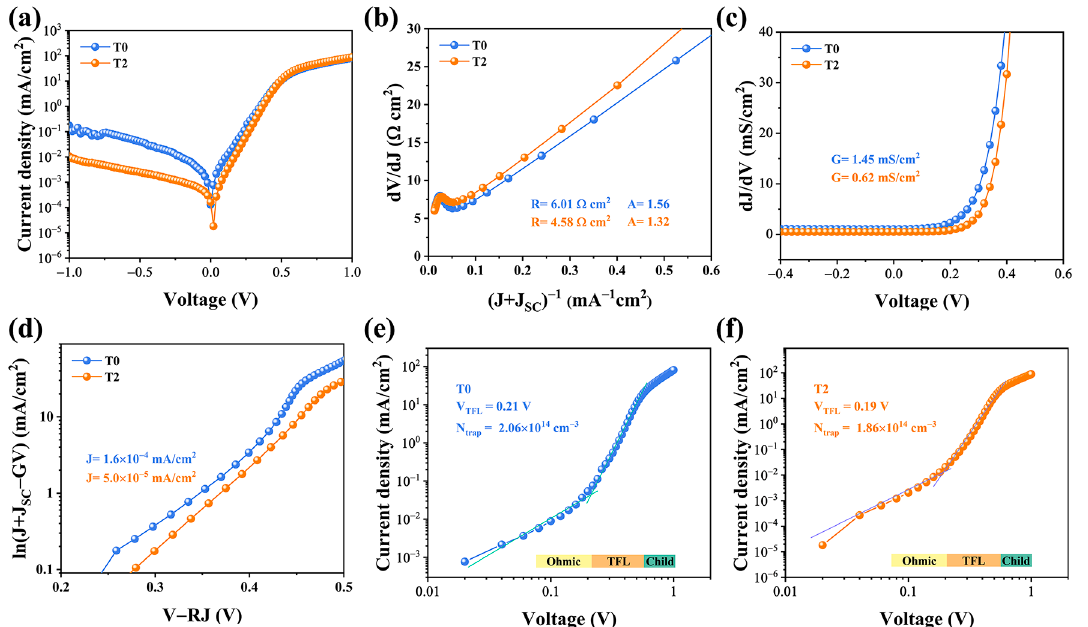
Figure 6. Electrical characteristics of the T0 and T2 devices include the following: ( a ) dark J -V curves; ( b ) series resistance R and ideality factor A; ( c ) shunt conductance G; and ( d ) reverse saturation current density J 0 . ( e , f ) The corresponding logarithmic J -V curves of the T0 and T2 devices.